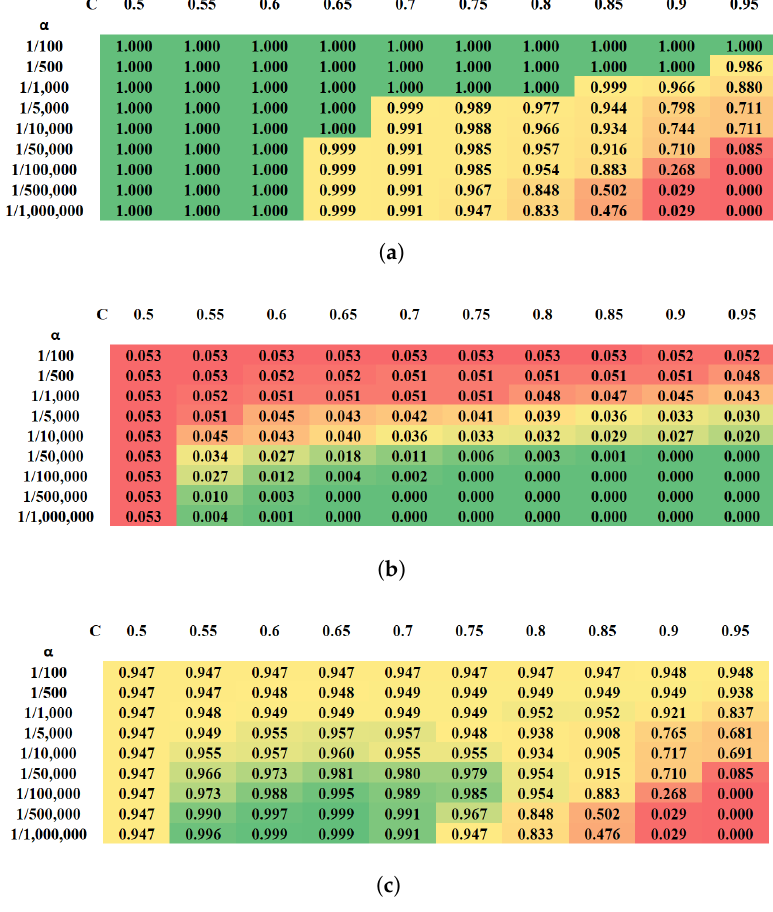
Figure 21. ( a ) True positive rate (TPR) changing with α and C . ( b ) False positive rate (FPR) changing with α and C . ( c ) KS-test results changing with α and C . Heat maps demonstrating the TPR, FPR and KS-test results changing with α and C . Best viewed in color.